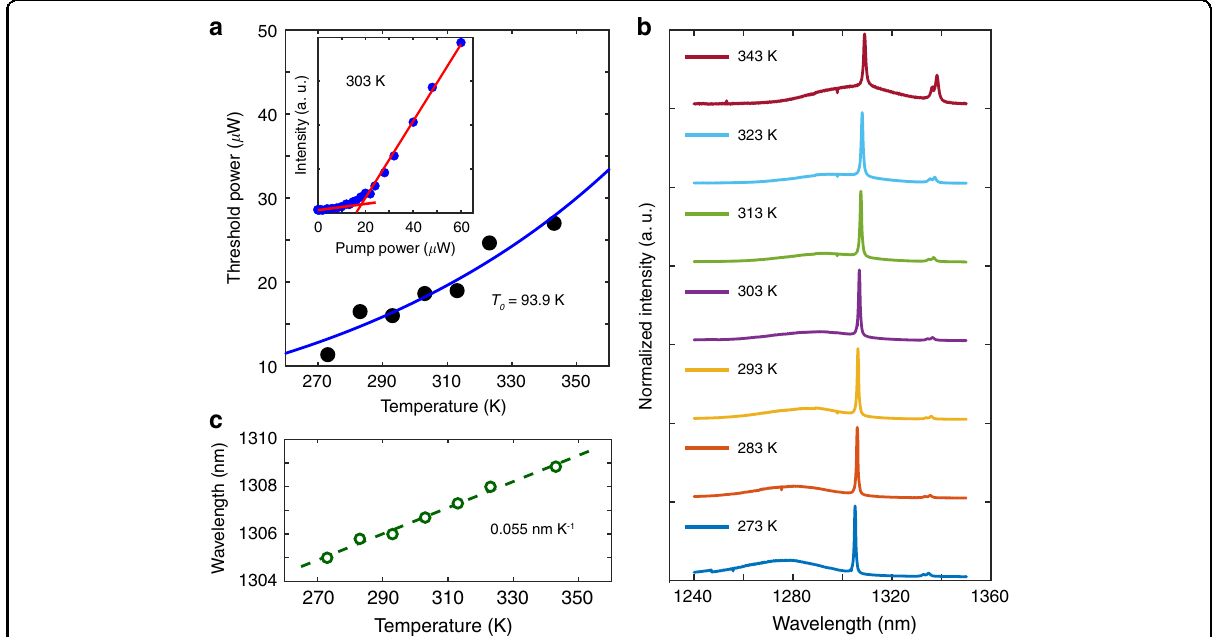
Fig. 5 Temperature dependent laser performance. a Temperature dependence of the lasing threshold, and the blue line represents the exponential fi t to the experimental data (black dots), revealing the characteristic temperature T 0 of 93.9 K. The inset shows the measured L – L curve of the laser at 303 K, indicating a threshold at 18 μ W. b Normalized lasing spectra at the pumping power 200 μ W (above threshold) from 273 to 343 K. c Temperature dependence of lasing wavelength at the pumping power 200 μ W. The dashed line is the linear fi t to the experimental data (brown circles), showing a linear wavelength-temperature tuning rate of 0.055nm K −